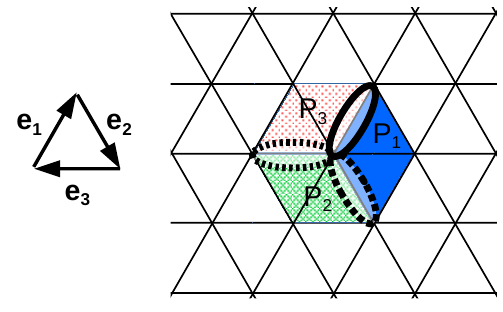
Figure 2: The three elementary plaquettes per lattice site, labelled P configurations of a dimer, indicated by the three ellipses, are labelled by the lattice site and the direction η ∈ { 1,2,3 } of the unit vector e η